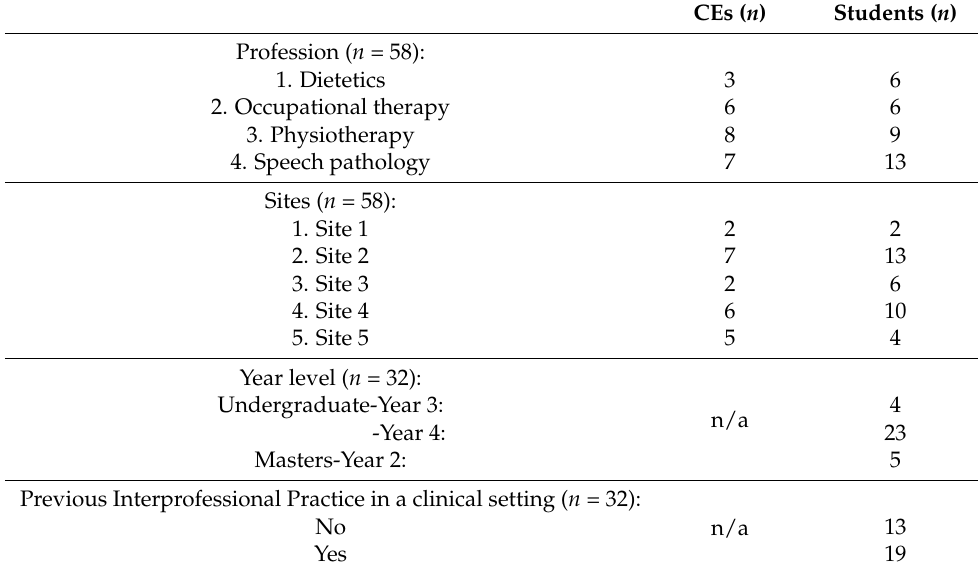
Table 1. Participant and placement